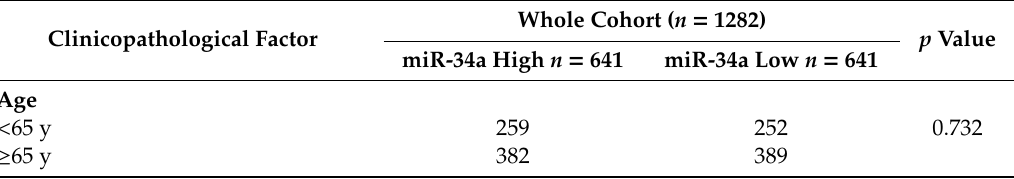
Table 1. Clinicopathological demographics of the high-miR-34a and low-miR-34a groups in the Molecular Taxonomy of Breast Cancer International Consortium (METABRIC)